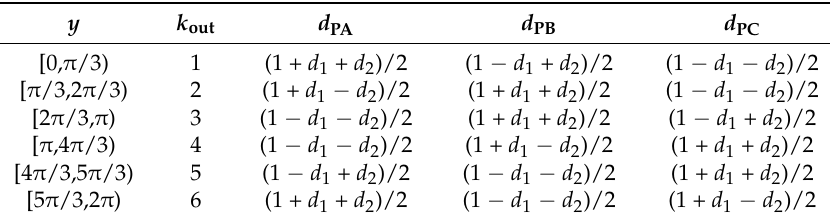
Table 2. The expression of d P µ when V ref is in different